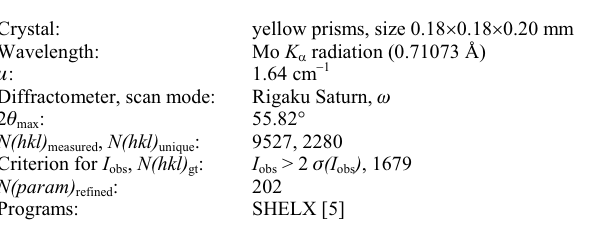
Table 1. Data collection and handling.